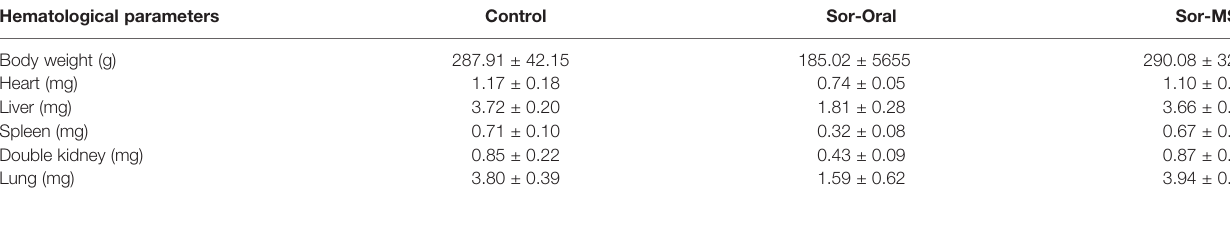
TABLE 6 | The effect of sorafenib formulations on immunode fi ciency rat ’ s hematological parameters. Main organs mass